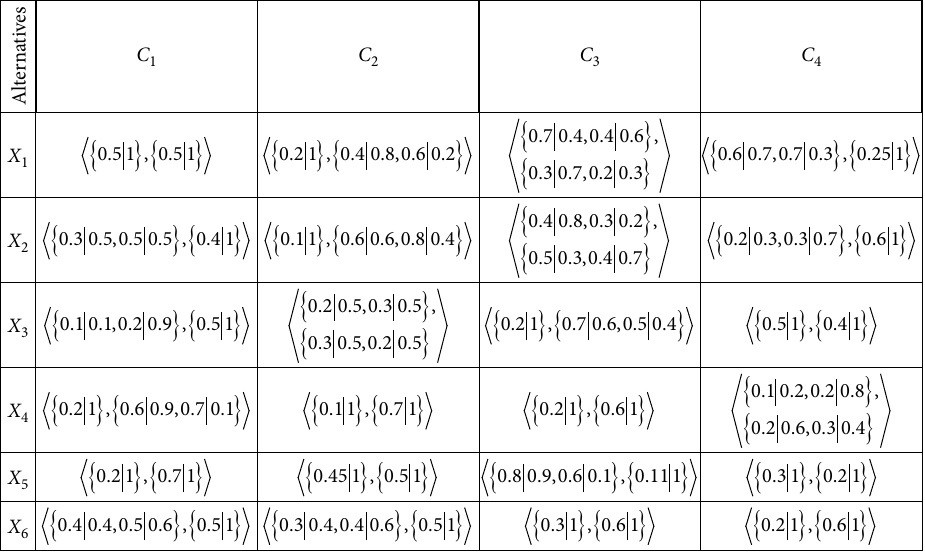
Table 3. The PDHF decision information matrix obtained by e 3 n r t e A l